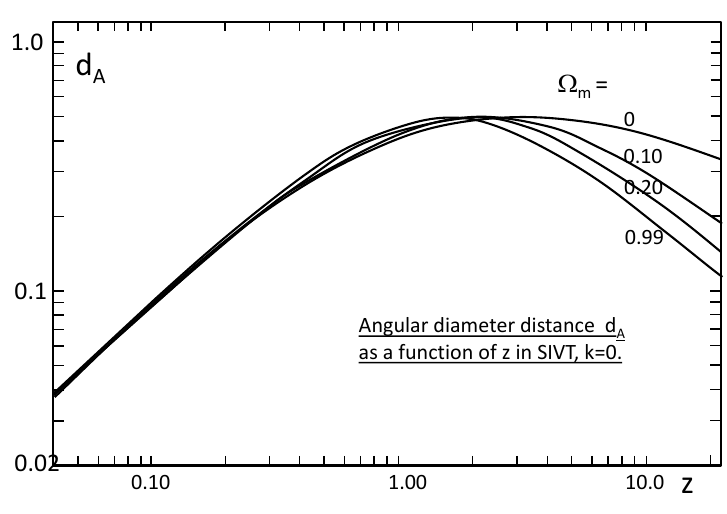
Figure 4. Comparison of the angular diameter distances for Λ CDM and SIV models of different density parameters Ω m [15], with the scales t 0 = 1, a 0 =